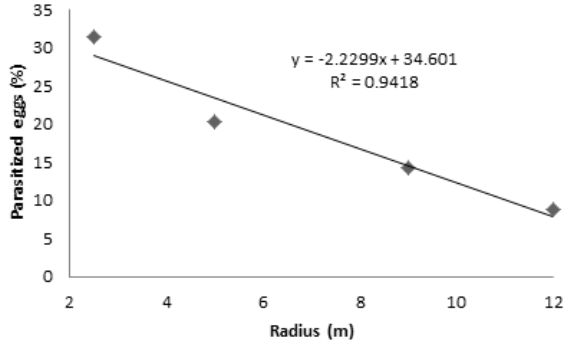
Figure 4. Scattering radius of Trichogramma pretiosum (Hymenoptera: Trichogrammatidae) and parasitism on eggs of the alternative host Anagasta kuehniella (Lepidoptera: Pyralidae) in cabbage (F= 32.38 e P=